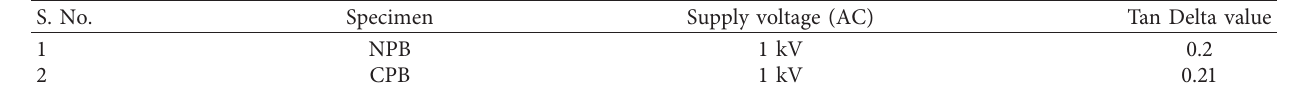
Table 2: Tan delta of specimens (NPB and CPB).